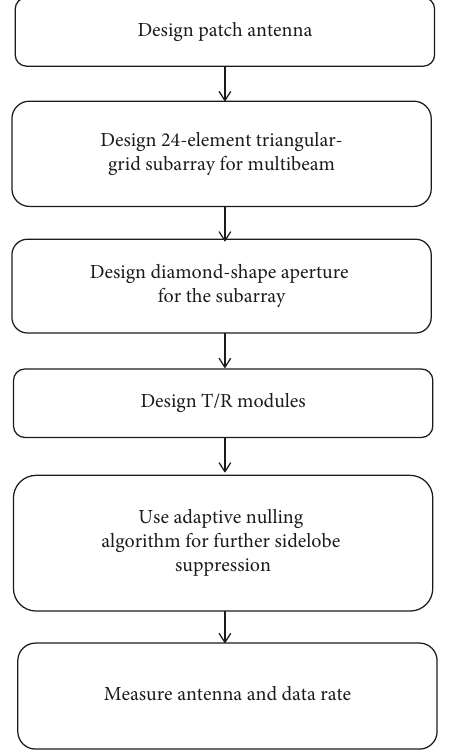
Figure 7: Overall design procedure.